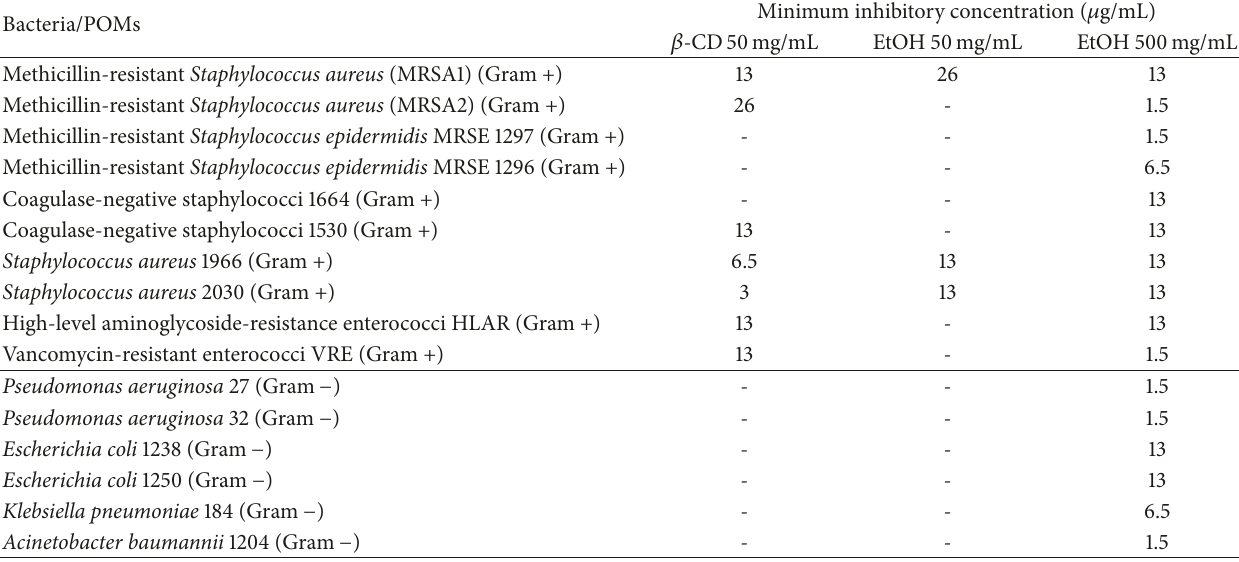
Table 1: Minimum inhibitory concentration ( 𝜇 g/mL) of different Gram + and Gram − bacteria obtained with 𝛽 -CD 50 mg/mL, EtOH 50 mg/mL, and EtOH 500 mg/mL extracts.